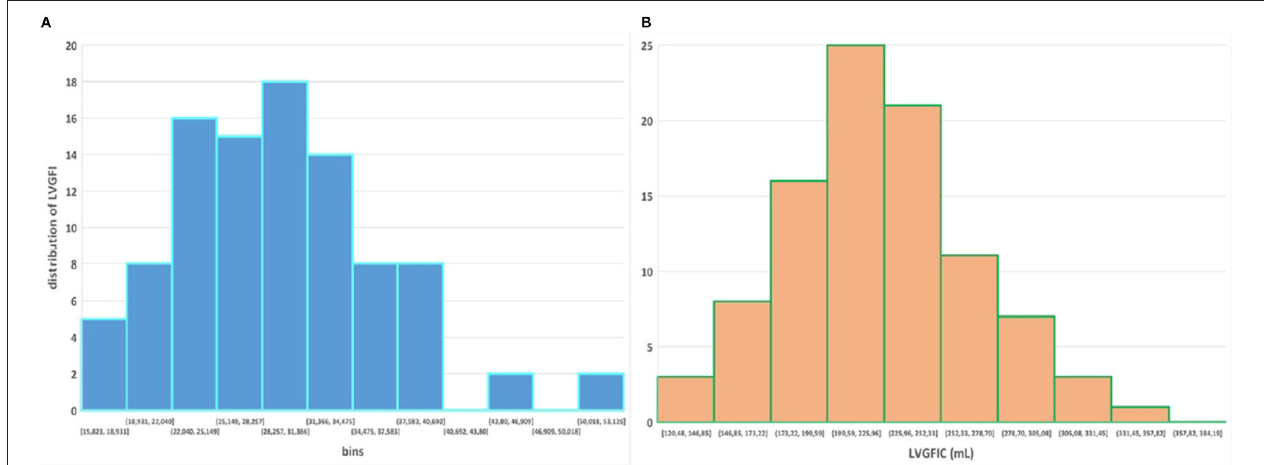
FIGURE 9 | (A,B) Histograms for LVGFI and LVGFIC, respectively. Compare with Figure 1 in Nwabuo et al. (2).